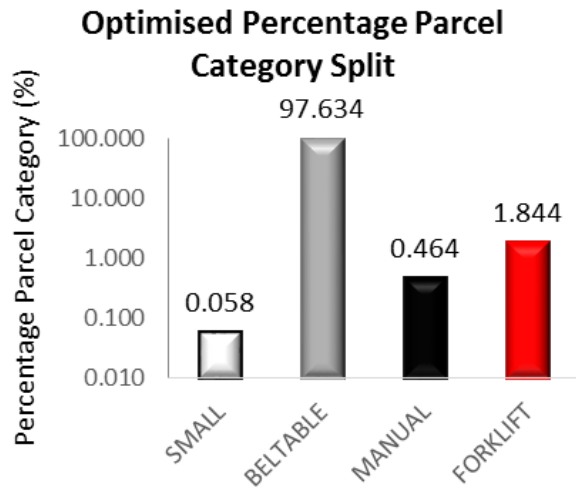
Figure 3: Analysis of the optimal parcel category percentage